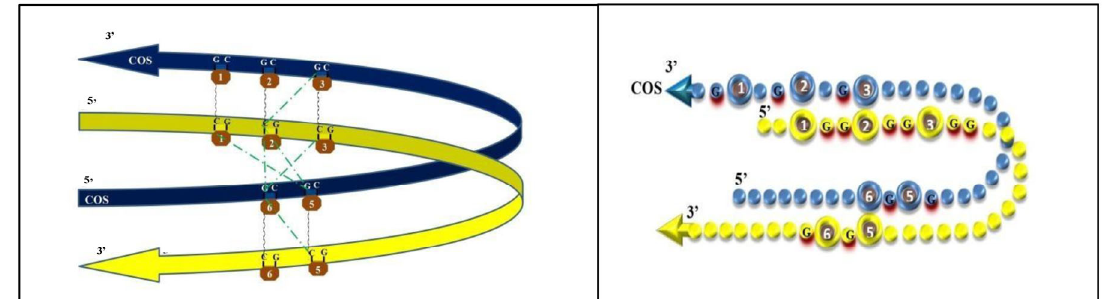
Figure 3. Graphic representation of looping strands (left panel); graphic representation by a pearl necklace model (right panel), with simulation of tight interaction between cytosines placed one another at their left, providing a cue for a rightward oscillation between DNA strands.